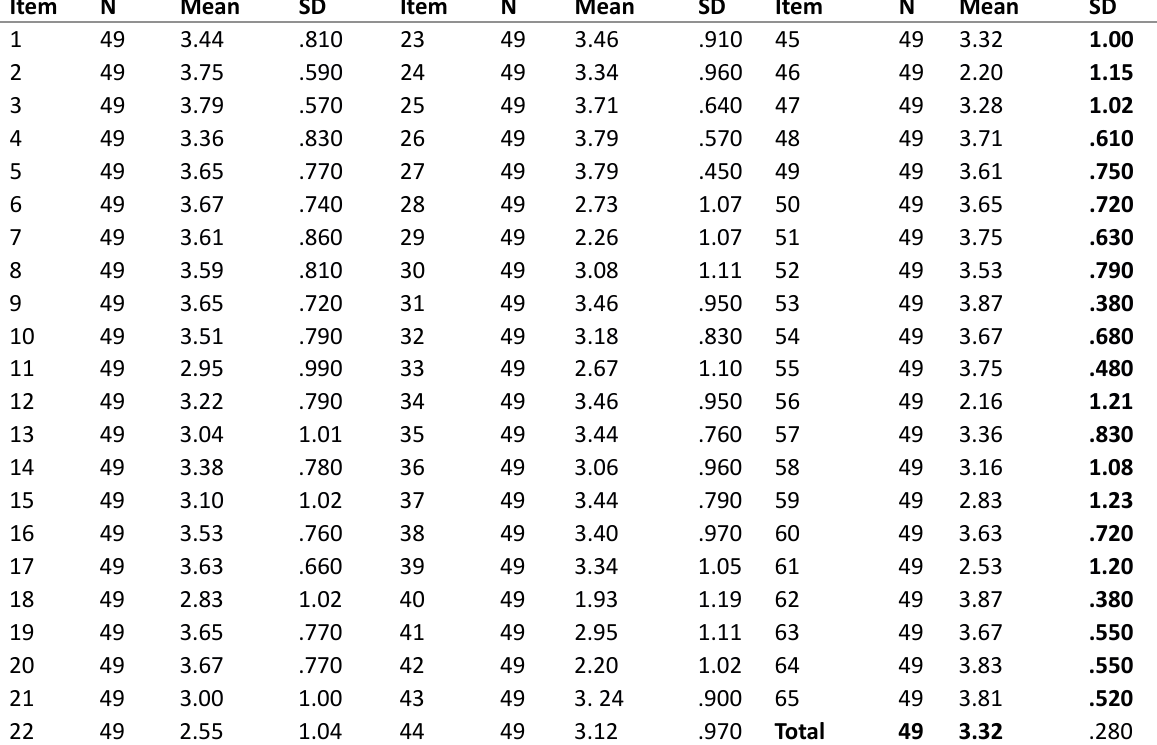
Table 2. Shows the mean and standard deviations of the social responsibility scale among physical education teachers SDMeanNItemSDMeanNItemSDMeanNItem